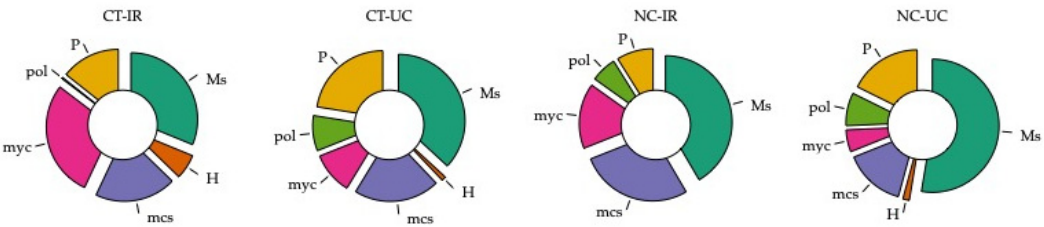
Figure 8. Canonical Correspondence Analysis (CCA) ordination biplot of the total dataset showing the environmental factors (arrows) and microarthropod group distributions (dots). Positioning of the microarthropod group along each arrow indicates the approximate ranking of the weighted average of the group with respect to that factor.